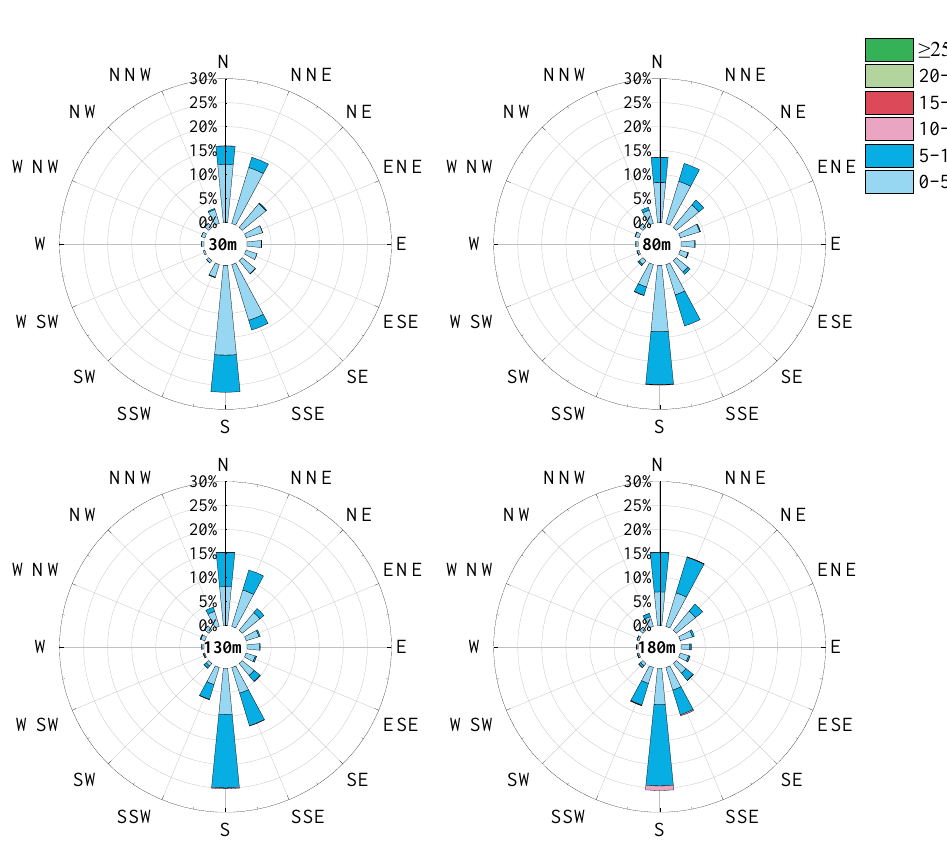
Figure 3. Wind rose at different heights.